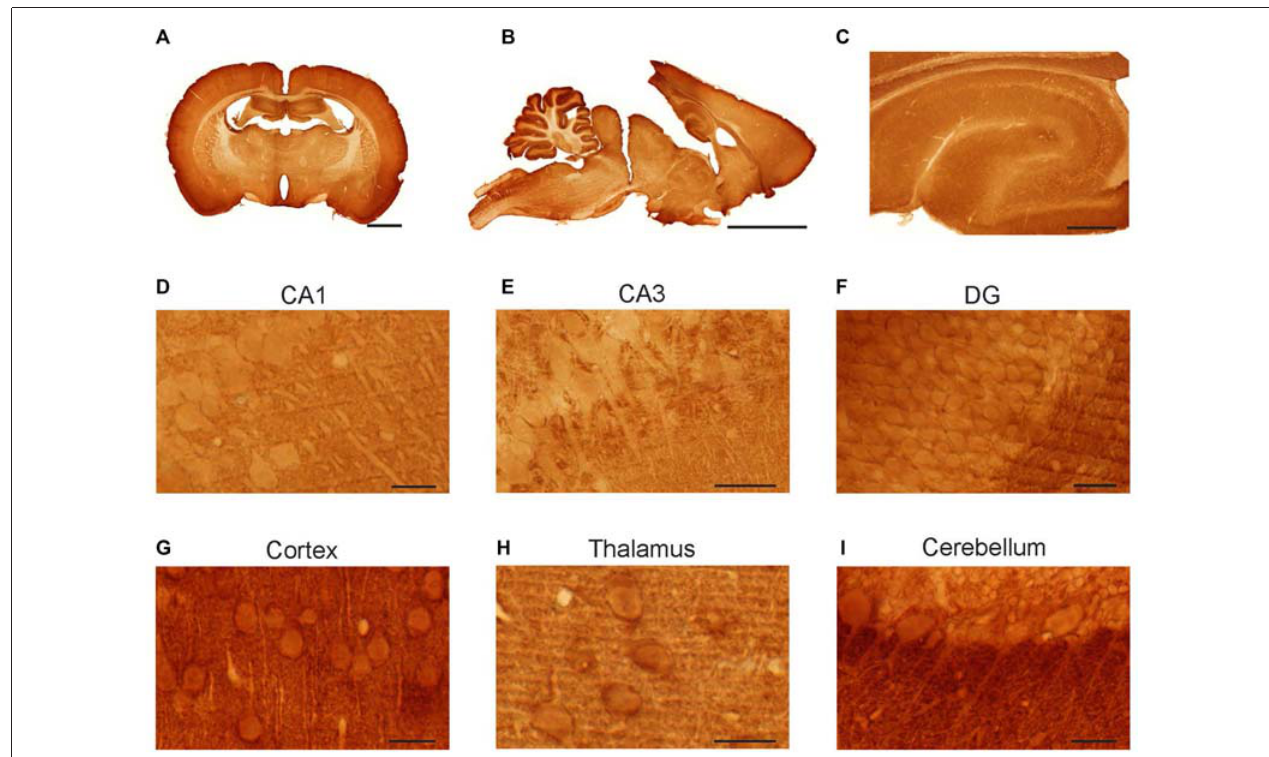
FIGURE 2 | Light micrographs of rat brain sections. Vibratome sections immunolabeled for syntaxin-1. Immunoperoxidase staining. Anti-syntaxin-1 produced staining of neurons in hippocampus, cerebellum, cerebral cortex and thalamus (A–C) . In the hippocampus the somata and proximal dendrites of pyramidal neurons were moderate stained in sub-regions of CA1 (D) and CA3 (E) , as were the granule cells in dentate gyrus (F) . Strong immunostaining was found proximal dendrites of Purkinje cells in the cerebellar cortex (I) , and in the pyramidal cells of the cerebral cortex (G) . Immunolabeling was also observed in thalamic neurons (H) .